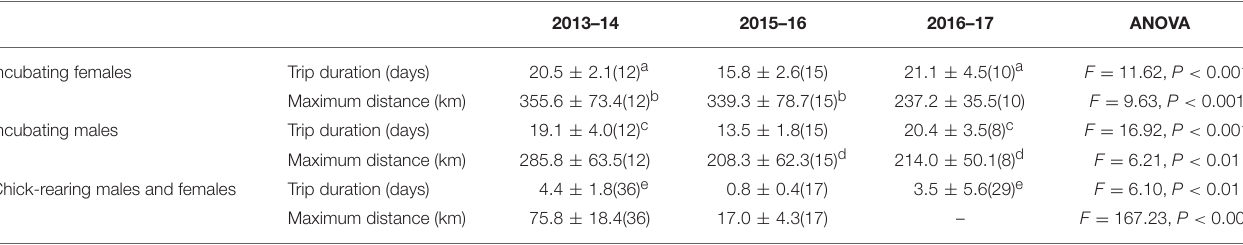
TABLE 1 | Mean values ( ± SD) of durations and maximum distances reached during foraging trips of Adélie penguins, by year and by phase of the reproductive